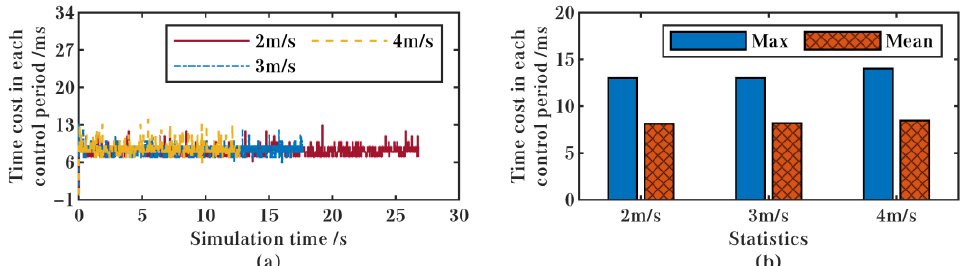
Figure 13. The real-time performance of the simulation at different speeds: ( a ) the time-series diagram; ( b ) the statistical diagram.